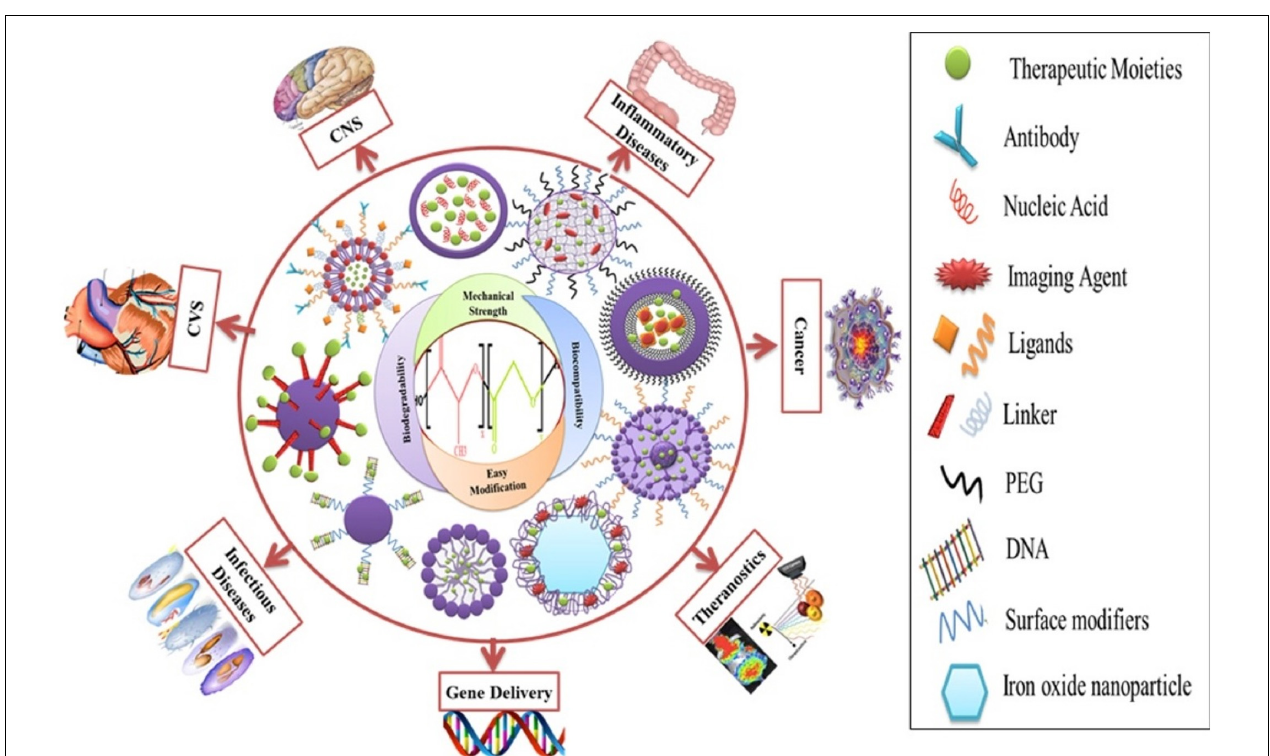
FIGURE 12 | Functionalized PLGA nanocarriers and their medical applications, reproduced from Mir et al.